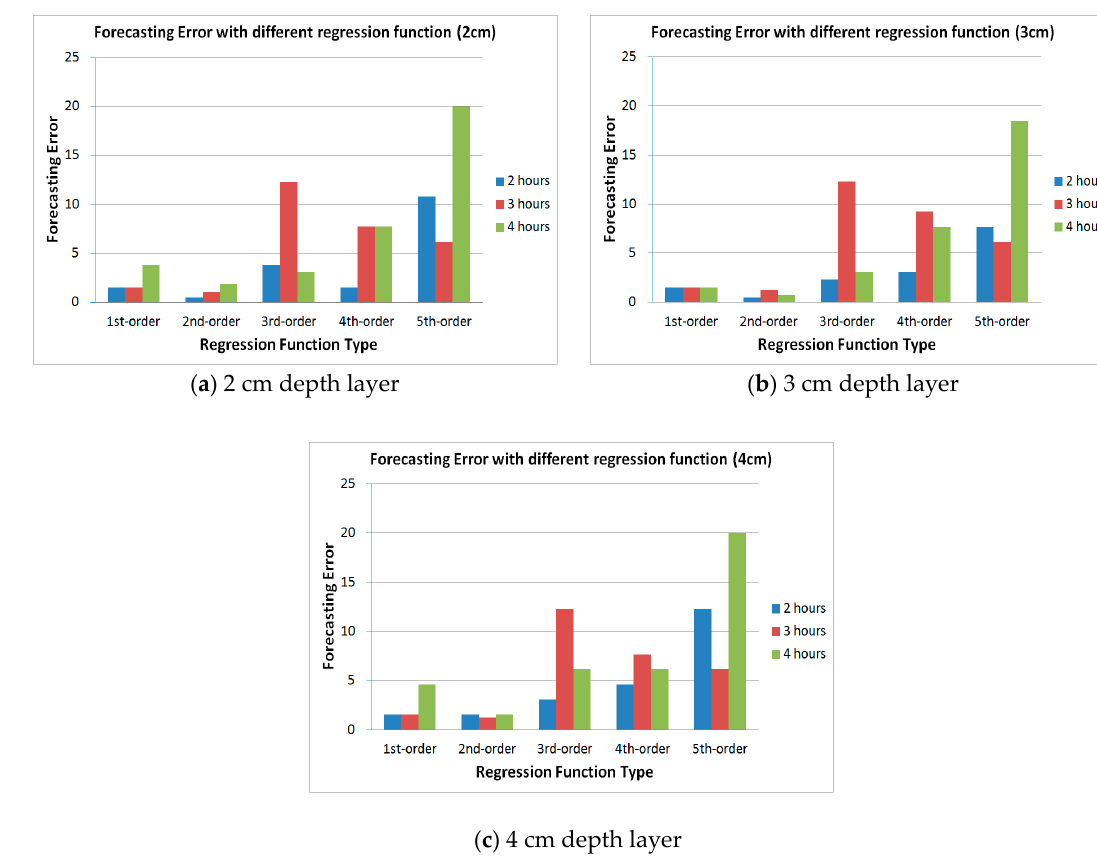
Figure 7. The forecasting errors of different order polynomial functions. The 1st-order to 5th-order polynomial regression function with different irrigation intervals are evaluated. The forecasting error is calculated by moisture level, which is ranged from 0 to 1023. ( a ) the results of the sensors placed at the 2 cm depth layer of soil. ( b ) the results of the sensors at the 3 cm depth layer of soil. ( c ) the results of the sensors at the 4 cm depth layer of soil.